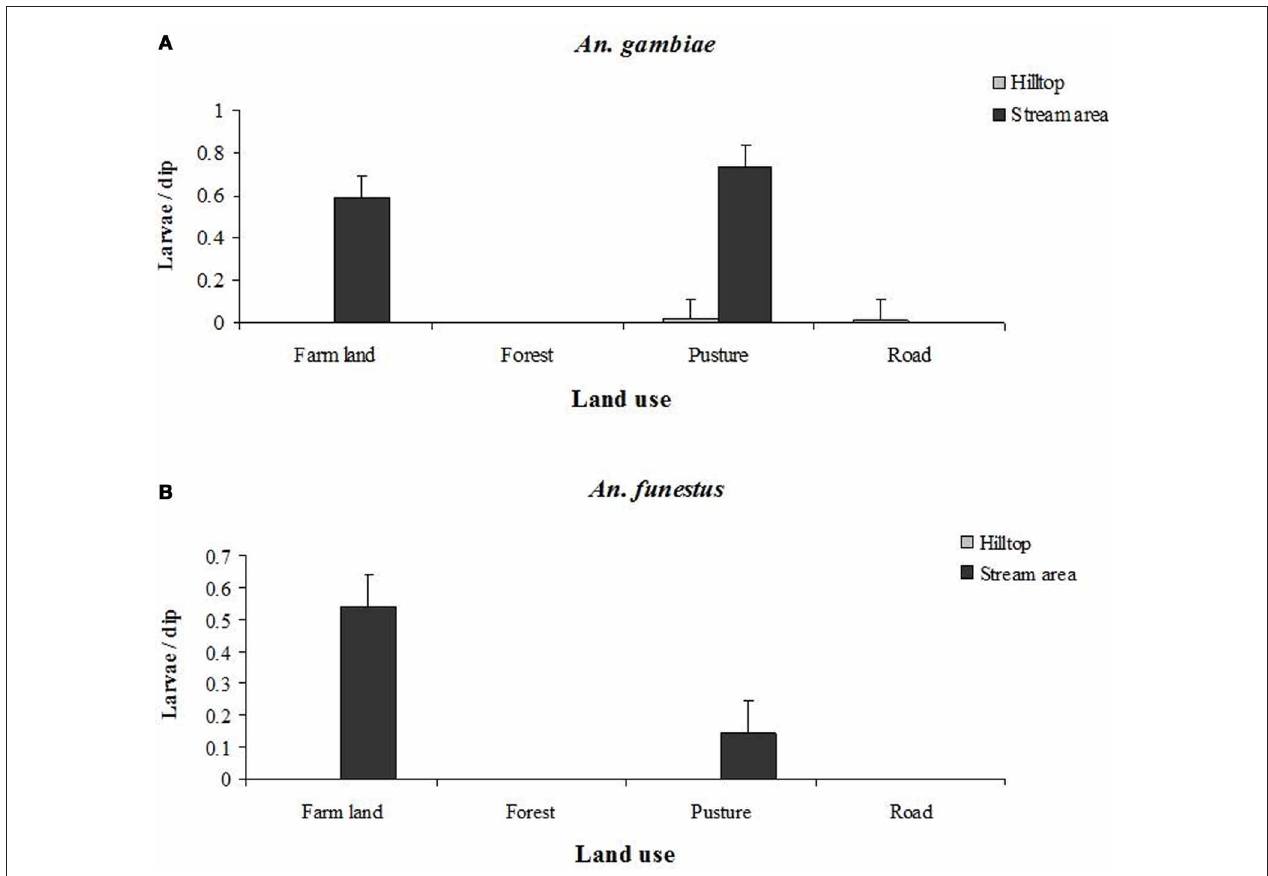
FIGURE 3 | Larvae density (larvae/dip) of A. gambiae (A) and A. funestus (B) among the different land use types found in Iguhu area in western Kenya highlands. Error bars show standard errors. Source: Himeidan (2009).